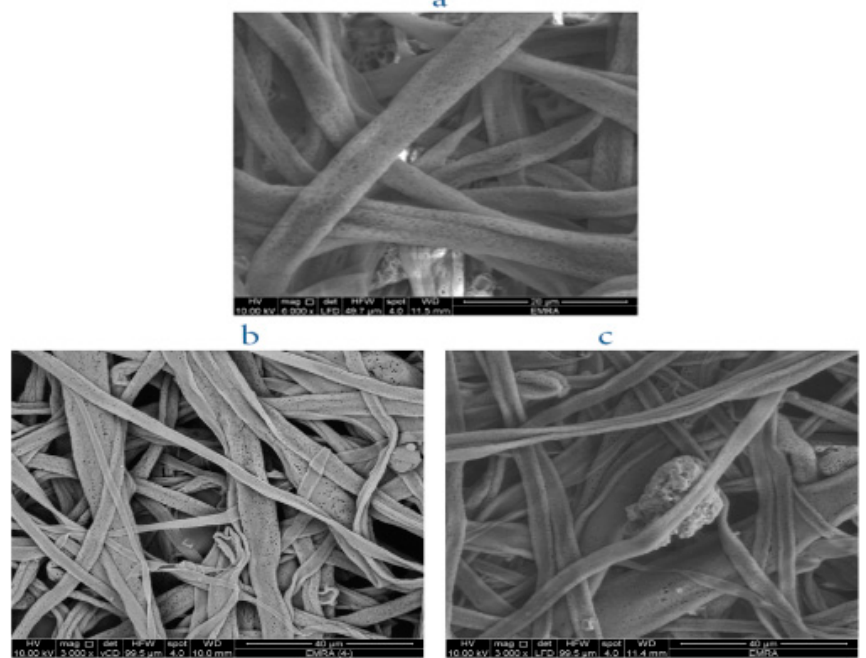
Figure 5. SEM images for the electrospun cellulose acetate fibers from DCM / acetone: ( a ) pure fabric, ( b ) fabric loaded with RHB by pre-treatment, and ( c ) fabric loaded with RHB by post-treatment.